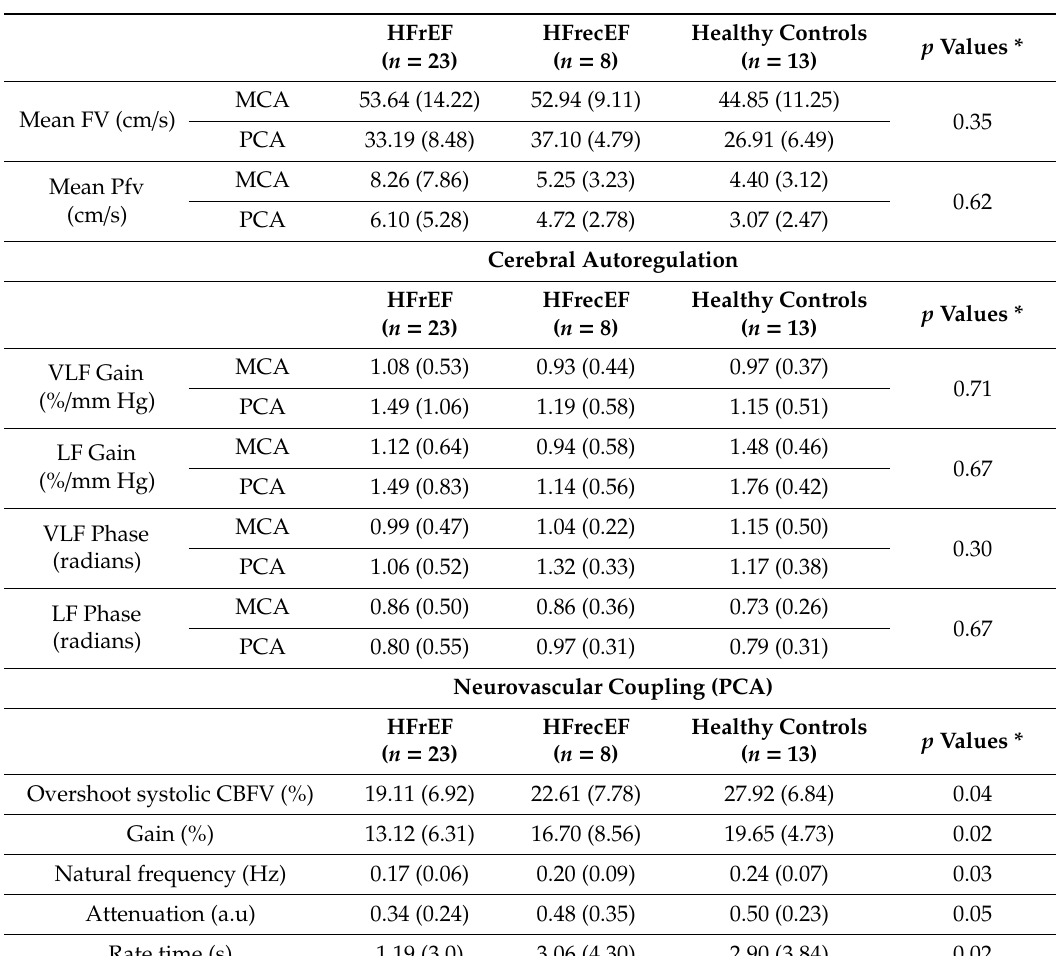
Table 2. Comparison of cerebrovascular regulatory parameters between of HFrEF patients, HFrecEF controls and healthy